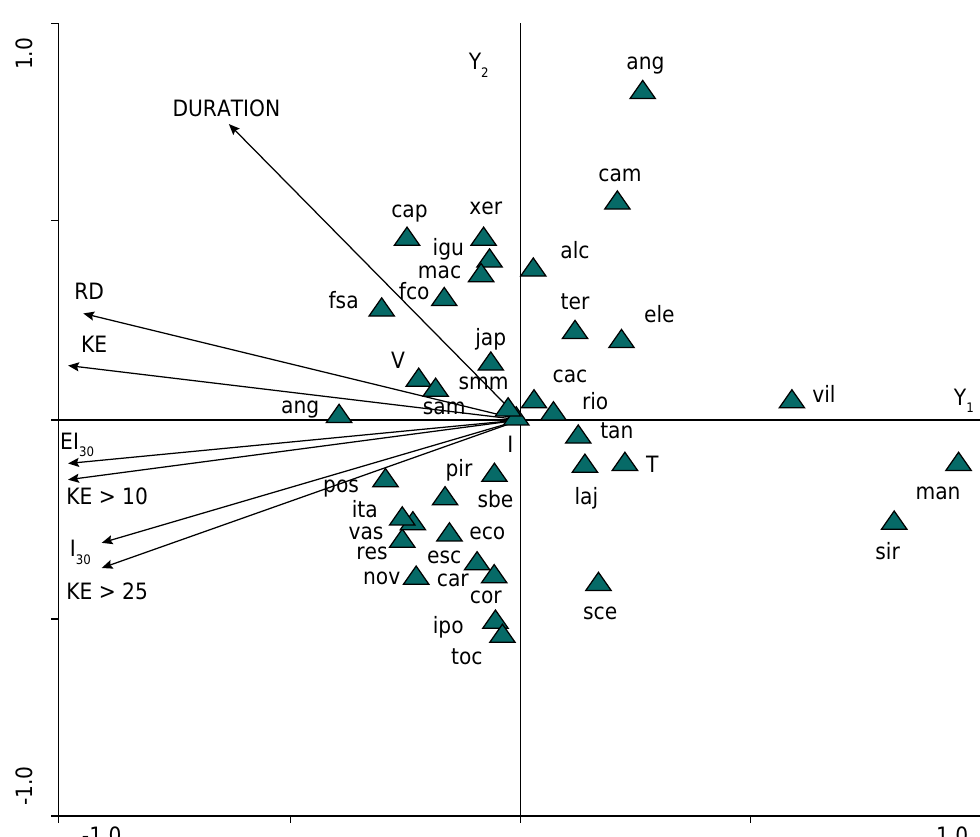
Figure 2. Principal component analysis of rainfall and erosivity characteristics considering the 36 rainfall stations and the three rainfall patterns (advanced - V, intermediate - I, and delayed -